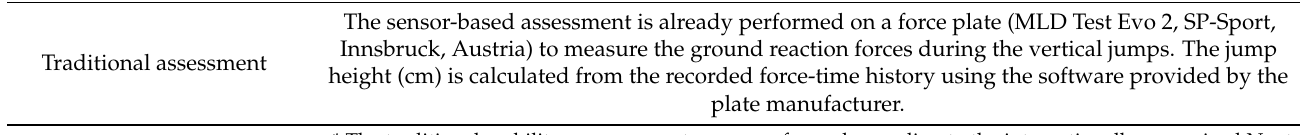
Passive flexion of the lower leg (knee joint)